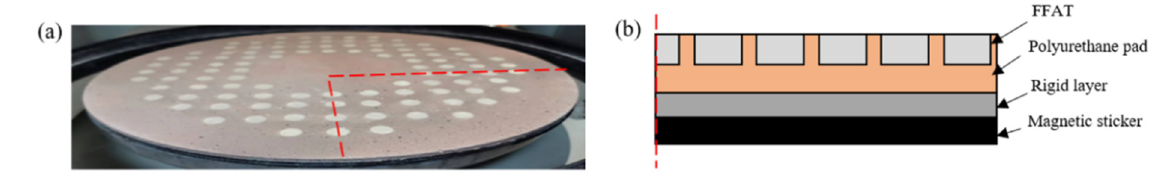
Figure 2. Polyurethane dilatancy pad: ( a ) physical diagram; ( b ) structure diagram.